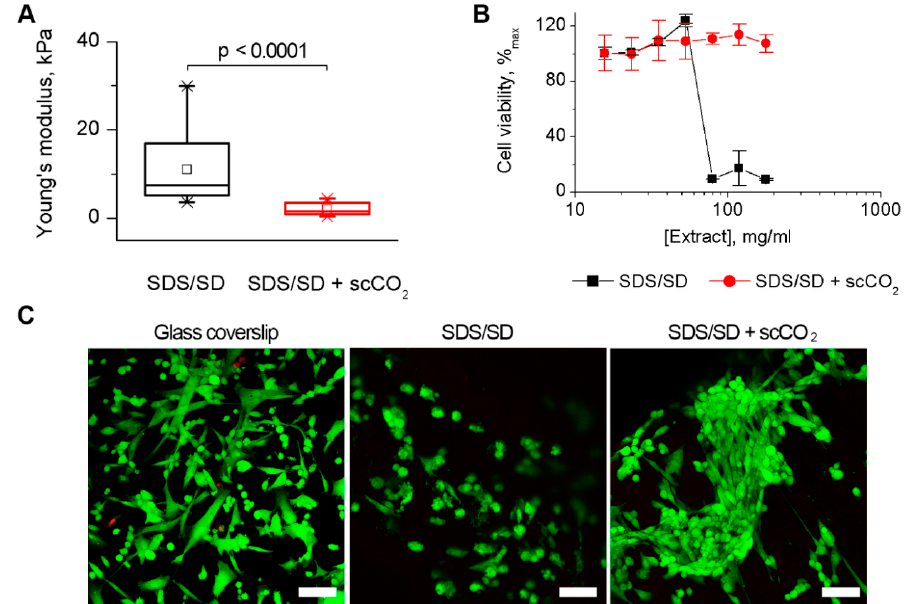
Figure 4. Mechanical characteristics and cytotoxicity of ovine aortic roots decellularized in a 0.5% sodium dodecyl sulfate / 0.5% sodium deoxycholate detergent solution (SDS / SD) and after the subsequent processing in scCO 2 medium (T = 37 °C, P = 25 MPa, t = 3 h). ( A ). Mechanical characteristics